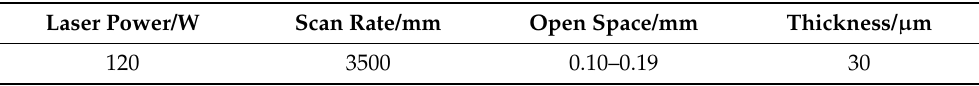
Table 2. SLM Process